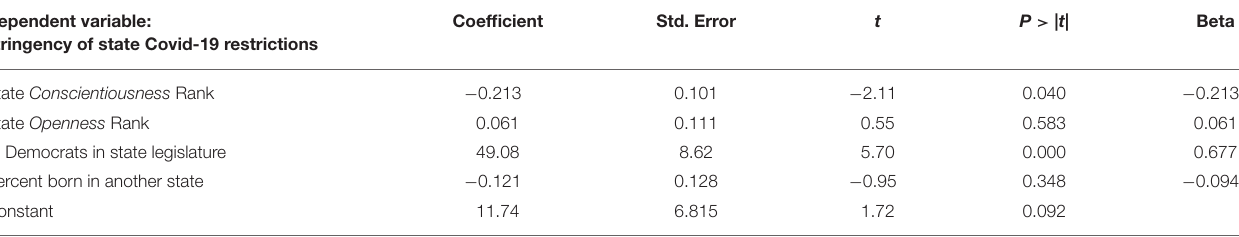
TABLE 3A | State Conscientiousness rank and political partisanship predict rank-order stringency of state Covid-19 restrictions. Dependent variable: stringency of state Covid-19 restrictions